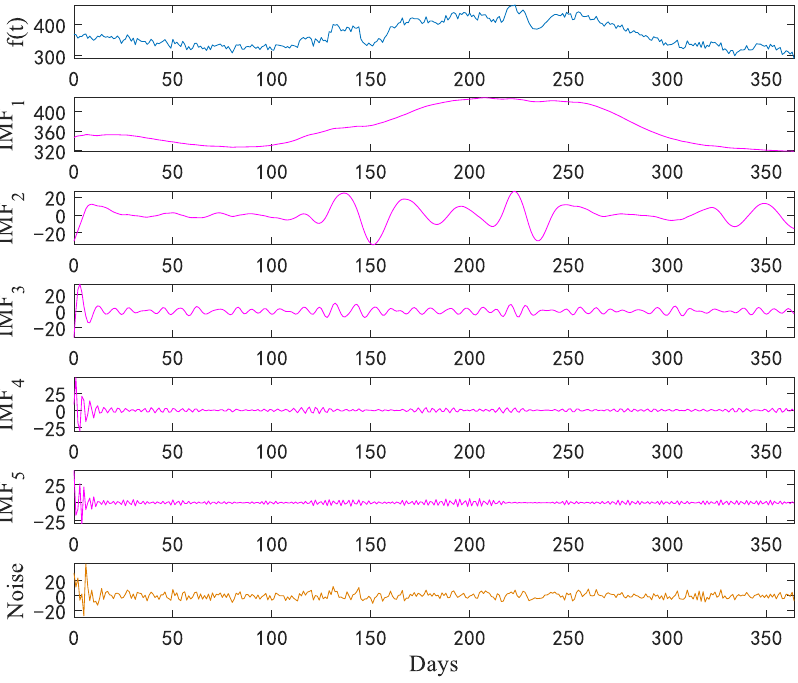
Figure 6. Original demand signal and mode decomposition diagram .